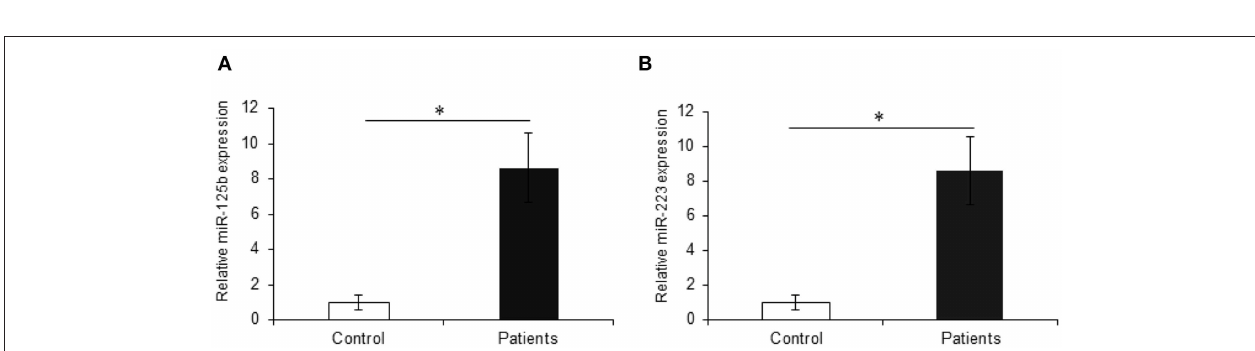
FIGURE 4 | Relative expression of miR-125b and miR-223 in UC patients. qRT-PCR for miR-125b and miR-223 was performed in UC vs. control ( n = 20 for non-IBD controls and n = 30 for active UC patients). (A) miR-125b exhibited significantly higher expression in UC patients as compared to controls with a change of